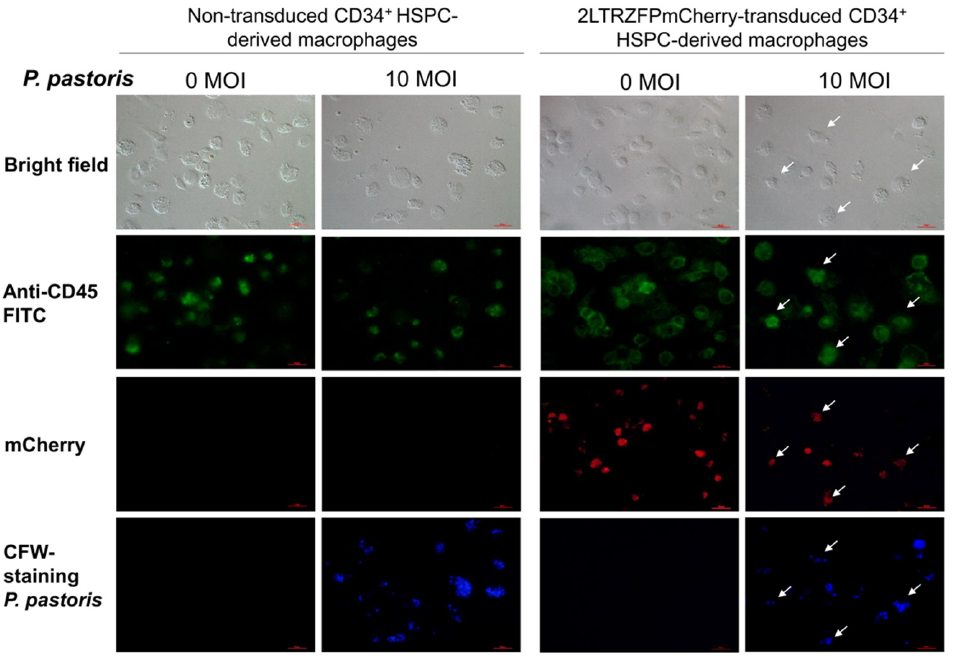
Figure 4. The phagocytic activity of the 2LTRZFPmCherry ‐ transduced CD34 + HSPC ‐ derived macrophages compared to the non ‐ transduced CD34 + HSPC ‐ derived macrophages. Green color (anti ‐ CD45 FITC antibody) represents the CD34 + cell ‐ derived macrophages. The 2LTRZFPmCherry and calcofluor ‐ white (CFW) staining of P. pastoris were shown in red and blue colors, respectively (white arrows).